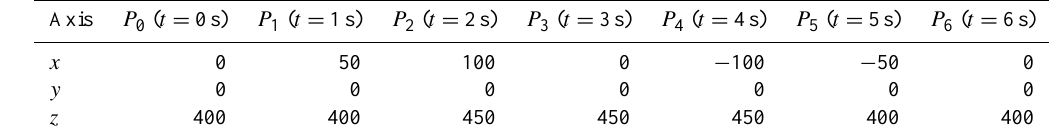
Table 3. Prescribed motion parameters of LARM tripod leg mechanism (mm).